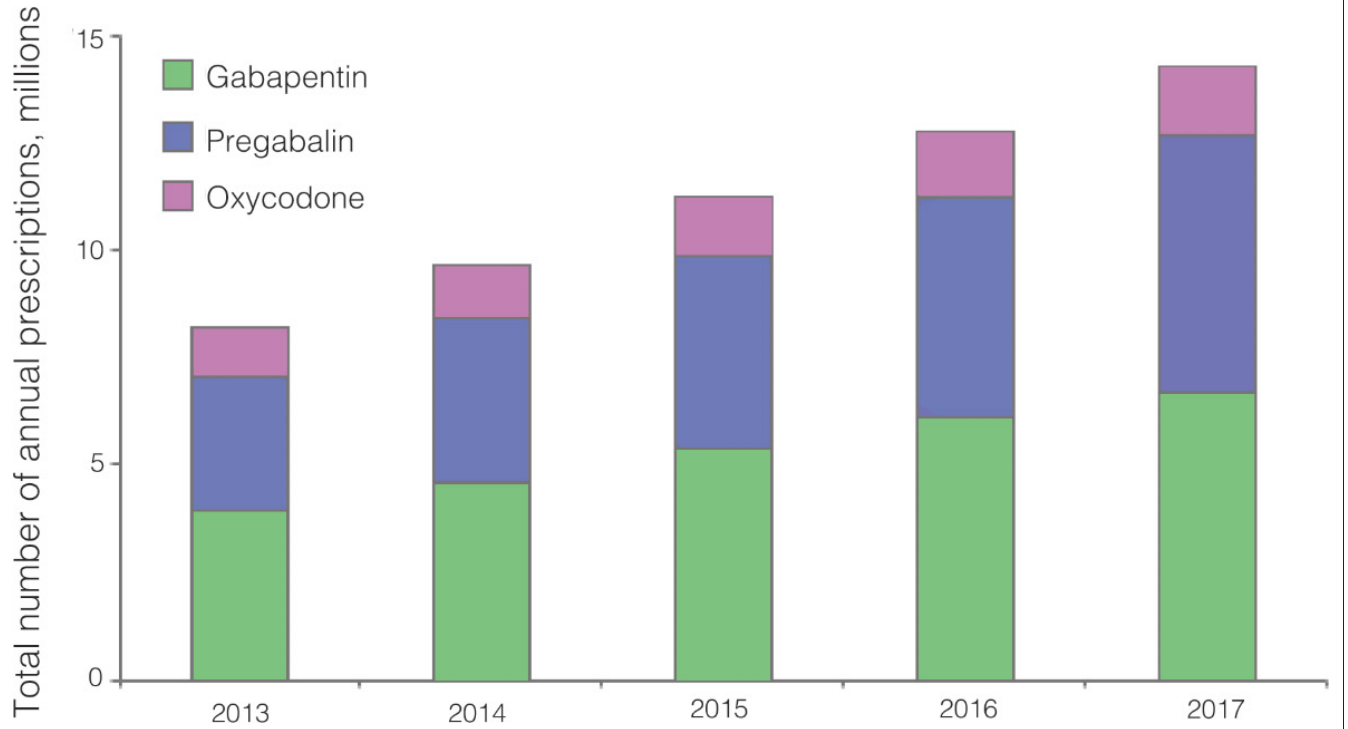
Figure 1 Absolute total number of prescriptions (in millions) of gabapentin, pregabalin, and oxycodone made in primary care per